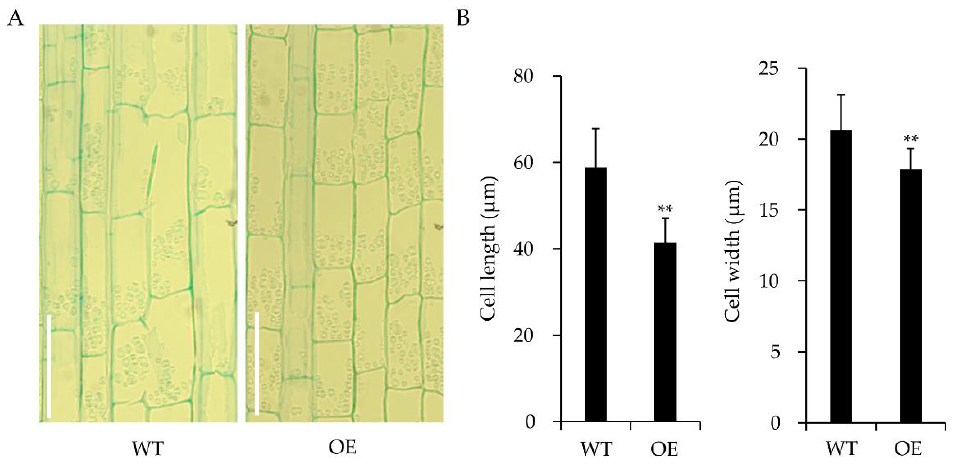
Figure 5. Overexpression of OsWRKY55 decreases cell size. ( A ) Longitudinal sections of the uppermost internodes of the main culms of the wild-type (WT) plants and transgenic lines overexpressing OsWRKY55 ( OsWRKY55 -OE-1). Scale bars = 50 µ m. ( B ) Cell size comparison of the uppermost internodes of the main culms in WT and OsWRKY55 -OE (OE-1) lines. Values shown are means ± SD (n = 3), ** p < 0.01 (Student’s t -test).